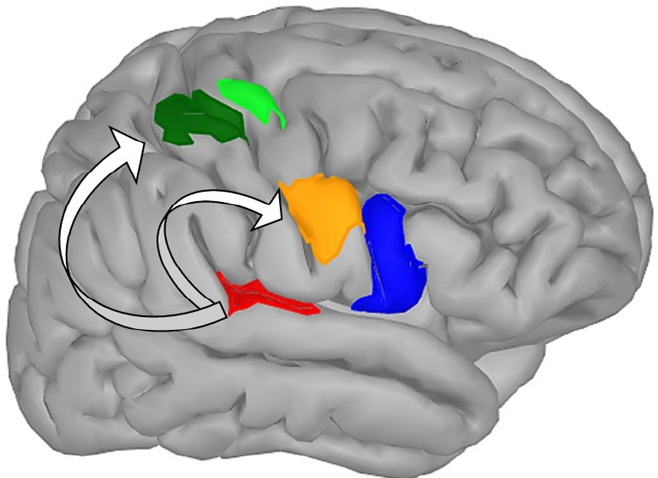
Figure 7. Auditory–motor training amplifies intracortical connectivity between auditory–motor network nodes (Red: auditory cortex, orange: premotor cortex dorsal, blue: inferior frontal gyrus, green: motor cortex, light green: premotor cortex ventral).